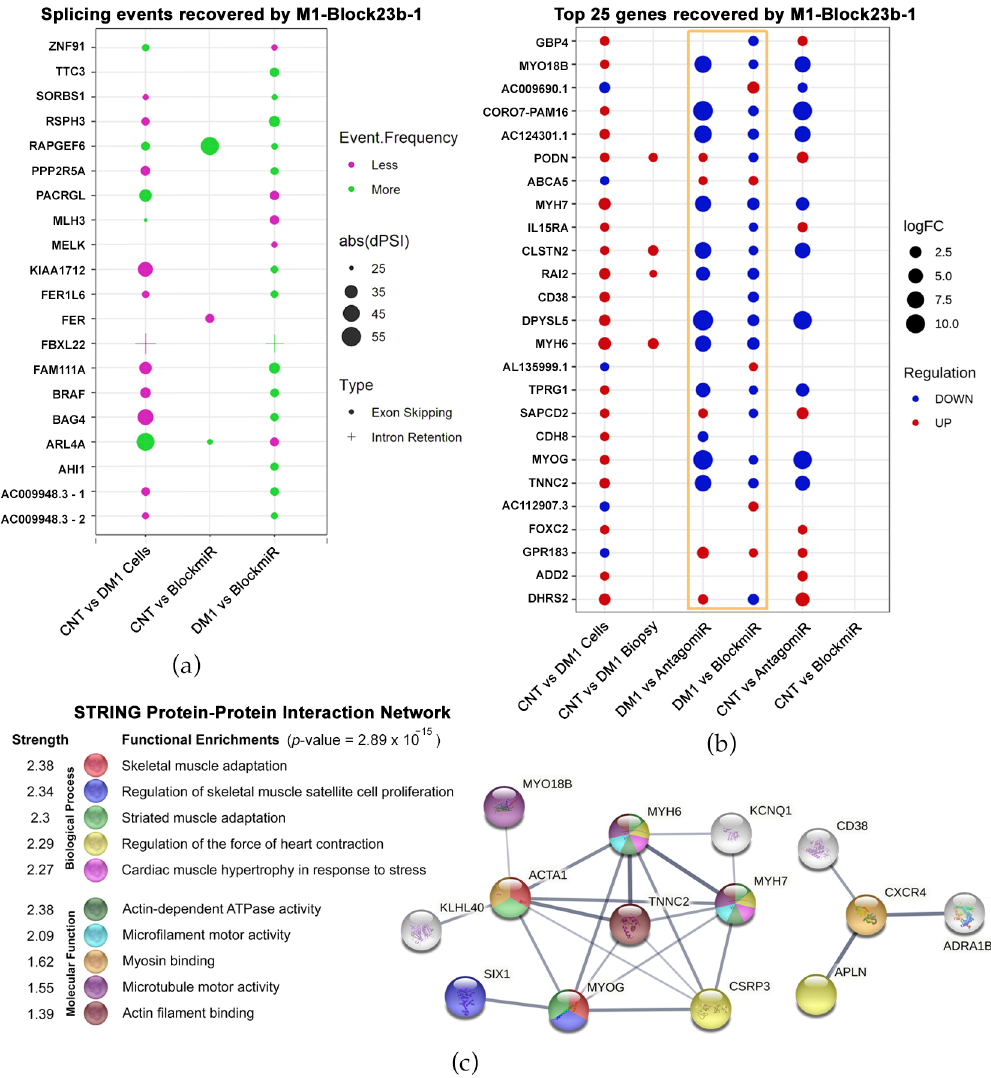
Figure 3. Transcriptomic recovery of blockmiRs through RNASeq analysis. ( a ) Splicing events were identified at exon/intron junctions and quantified using delta percent spliced-in (dPSI). Events were filtered for greater than 25% dPSI (represented by geometric point size), adjusted p -value < 0.05, and >10 reads. ( b ) Geometric points are plotted for the top 25 genes that showed total recovery after treatment with the blockmiR. Point size represents the strength of the log2 fold change, while the color represents the under- or over-expression of each comparison. ( c ) The 135 genes with total recovery by the blockmiR were analyzed with GOterm with 14 edges found over-represented. These edges were searched in the STRING Protein-Protein Interaction Network database to fi nd both functional and physical protein associations. Line thickness re fl ects the strength of supporting data. Reproduced/adapted from [29] Universitat de València, 2022.